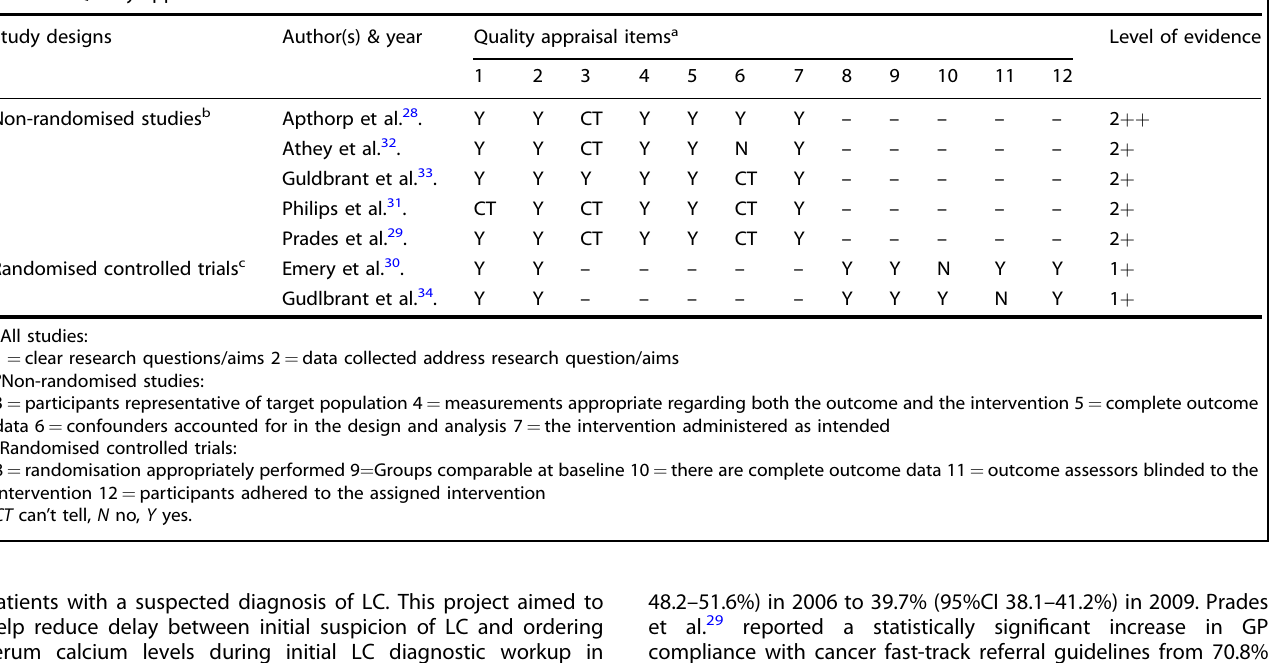
Table 2. Quality appraisal and level of evidence assessment.